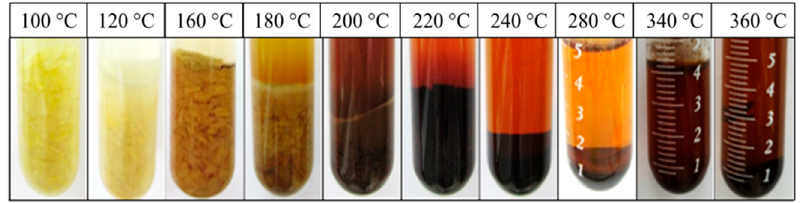
Figure 3. Photographs of 21-year-old OPT (OPT21) after being subjected to sub-CW at various temperatures for 5 min.